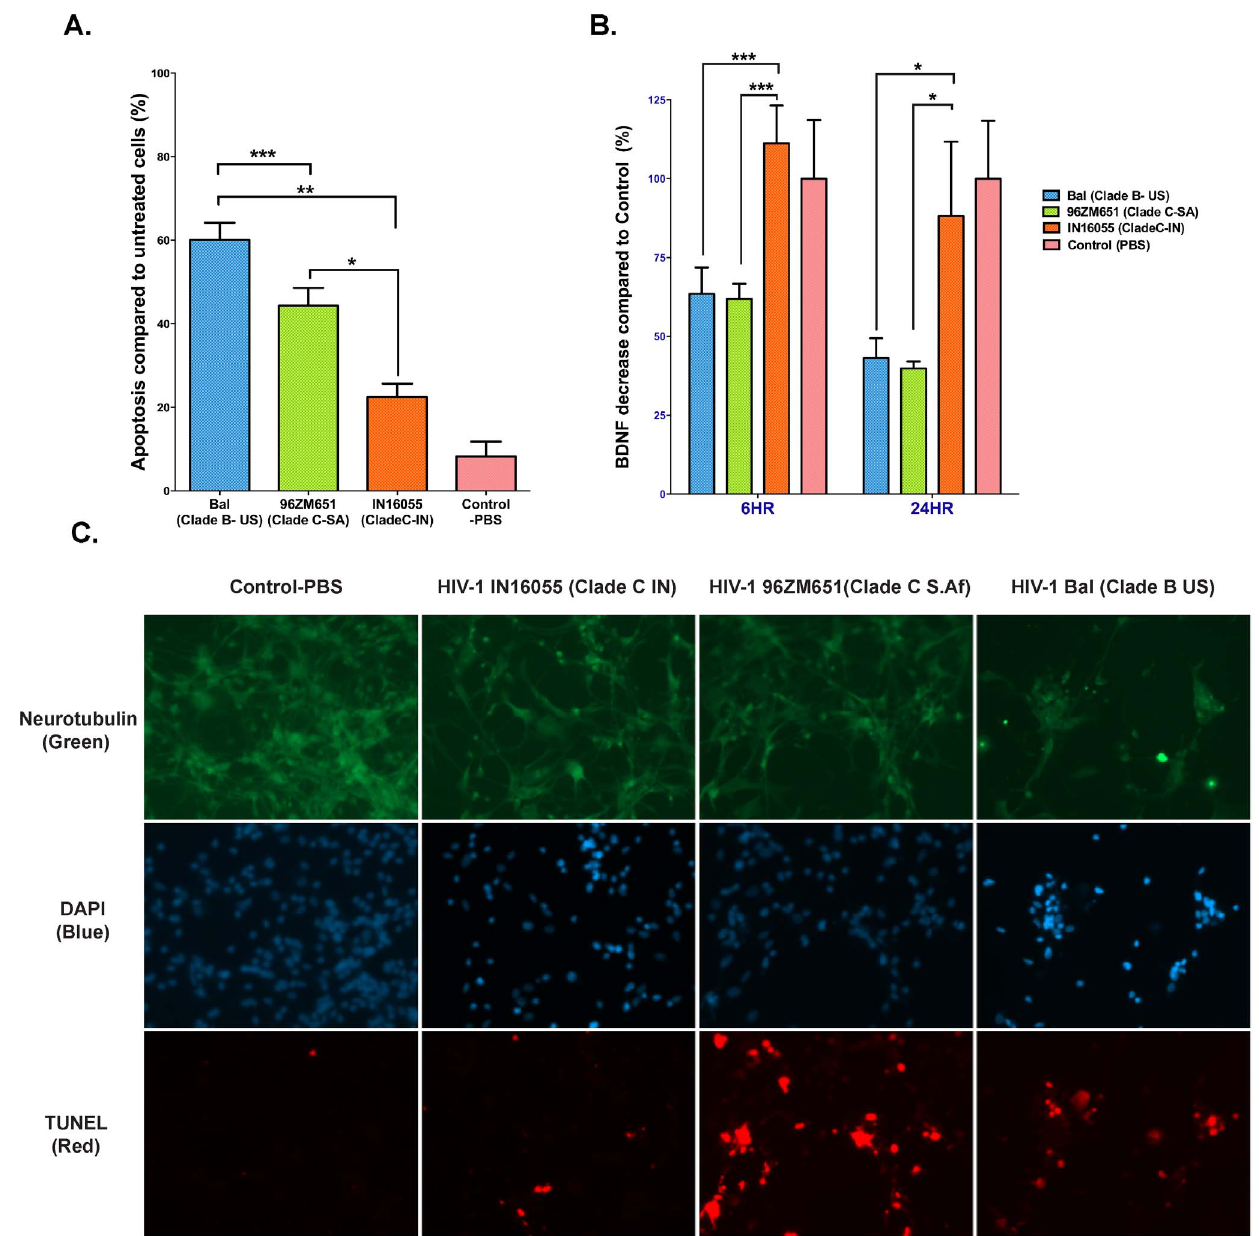
Figure 4. Recombinant gp120 proteins cause apoptosis in Primary Human neurons and reduce BDNF levels. A. gp120 mediated neuronal apoptosis . Primary Human Neurons were treated with 1 nM each recombinant gp120 s from representative US-B (HIV-1 Bal ), Southern African HIV-1C (HIV-1 96ZM651 ) and Indian HIV-1C (HIV-1 IN16055 ) isolates. Percent TUNEL positive cells from 20 different fields in 3x wells per treatment were analyzed and the level of apoptosis was determined. Similar to what was determined using immuno-depletion of gp120 in HIV-1-infected supernatants, the recombinant gp120 from Indian isolate showed a significantly lower percentage of neurotoxicity. B. gp120-mediated effect on BDNF release . Supernatants were collected from the primary human neurons following treatment with recombinant gp120s at 6 and 24 hours. Secreted BDNF levels were measured using ELISA and the results were plotted as a percentage of the Control (PBS). Both HIV-1 Bal (US clade-B) and HIV-1 96ZM651 (Southern African clade-C) gp120s resulted in a 40% decrease in secreted BDNF levels at 6 h and a decrease of 60% at 24 h as opposed to HIV-1 IN 16055 which showed no decrease at 6 h and a 10% decrease at 24 hours compared to Control (PBS). C. Neuronal apoptosis caused by recombinant gp120 proteins. Tunnel stained primary human neurons co-stained with anti-neurotubulin antibodies and DAPI (Prolong Gold anti-fade with DAPI, Invitrogen) to verify the direct effect of recombinant gp120 on neuronal death. The four panels show representative fields for neurons treated with PBS and 1 nM recombinant gp120 s from Indian HIV-1C, Southern African HIV-1C and US-B, isolates. Neurons treated with Southern African clade C gp120 and US- Clade B show greater neurotoxicity. (*p , 0.05; ** p , 0.01; *** p , 0.005). doi:10.1371/journal.pone.0107074.g004 motif of Tat is critical for interaction with NMDAR receptor on ulence of HIV-1C has been primarily attributed to C31S the neurons [13]. Therefore, until now, the decreased neurovir- polymorphism. In this study, we have shown that in addition to